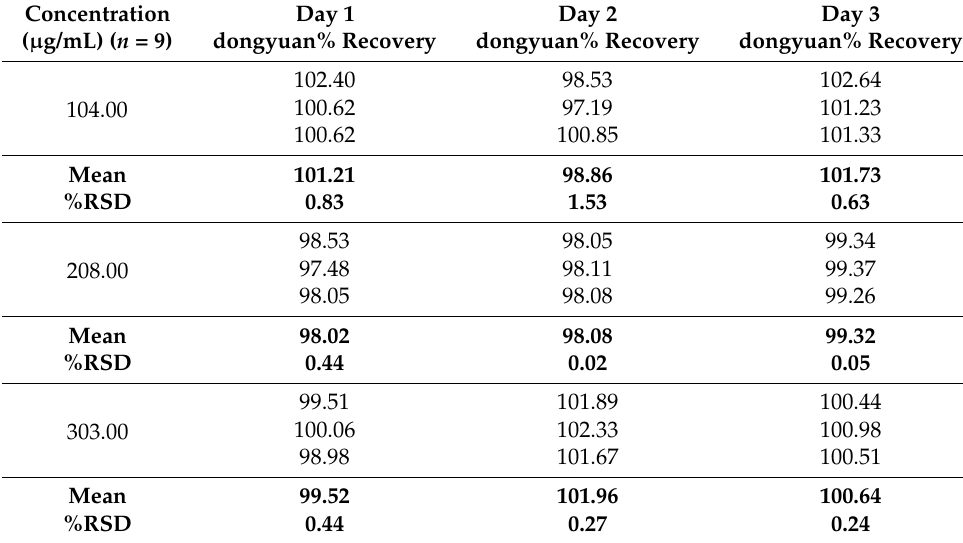
Table 3. Results obtained during inter-day precision testing of TZD.